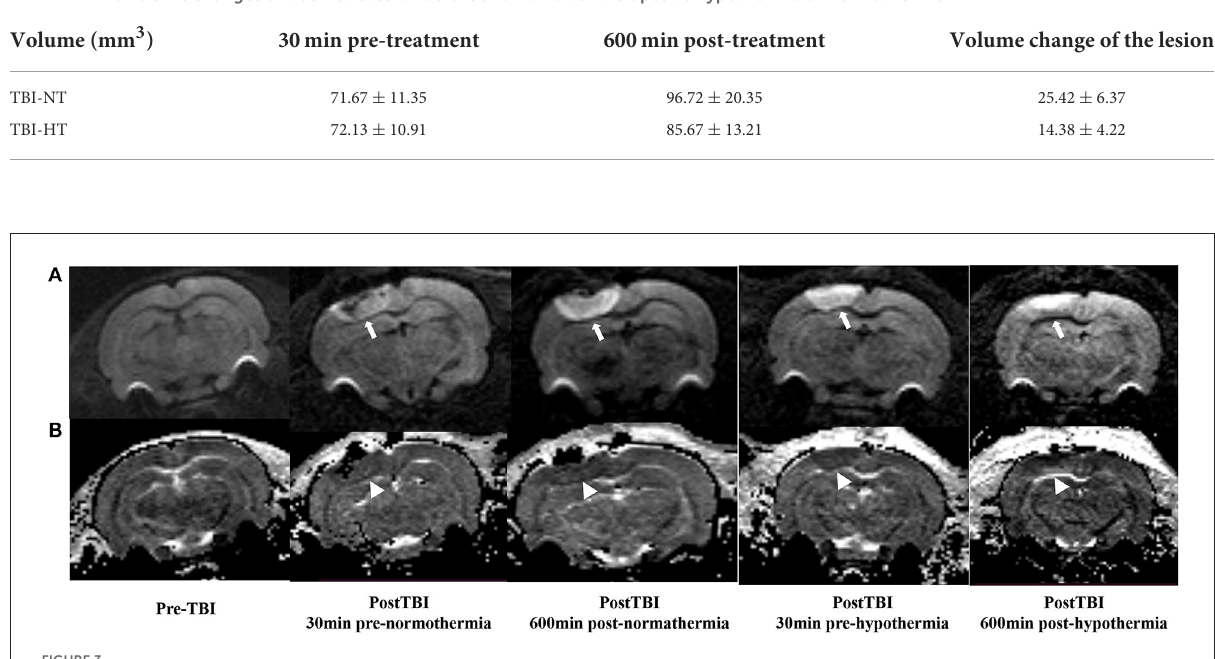
TABLE 2 ADC volume changes of traumatic lesion before and 10h after therapeutic hypothermia or normothermia.